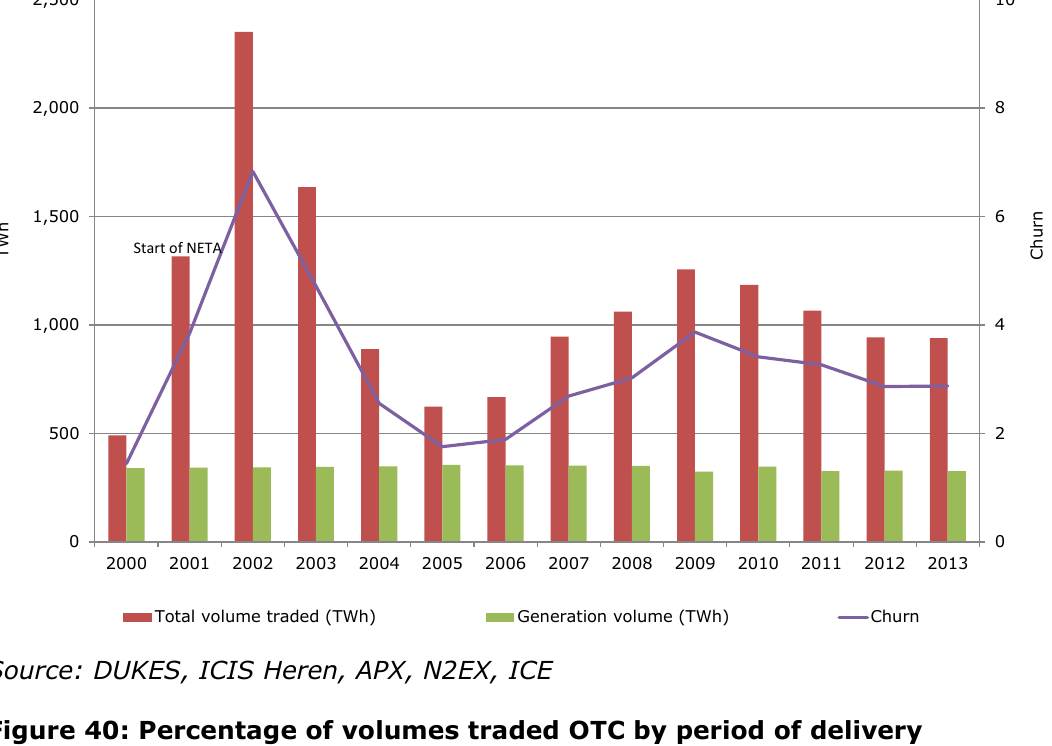
Figure 39: Wholesale electricity: overall volumes traded and degree of churn